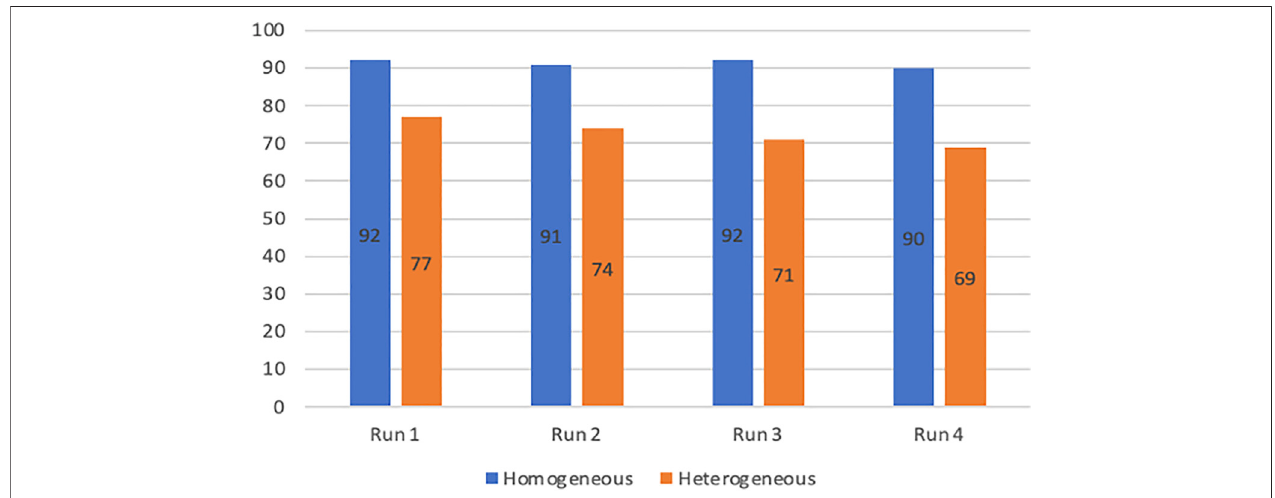
FIGURE 1 | Yields of styrene carbonate obtained after four runs in the presence of Salophen-tBu-Cr (in blue) or Salophen-tBu-Cr@{NH 2 }-SBA-15 (in orange). Conditions: Styrene oxide (5.6 mmol), Bu 4 NBr (0.1 mmol), soluble or supported Salophen-tBu-Cr (0.05 mmol) in 13 ml of benzonitrile under 11 bar of CO 2, 7h, 80 ° C.